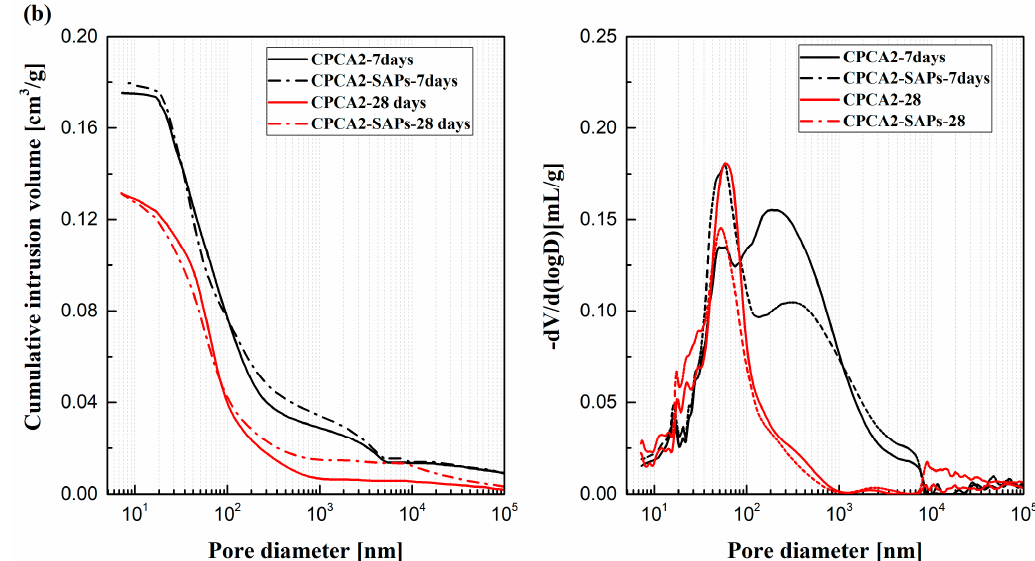
Figure 8. Cumulative intrusion pore volume and pore size distribution of the sample with or without SAPs ( a ) cement paste mixed with alkali accelerator; ( b ) cement paste mixed with alkaline free accelerator.